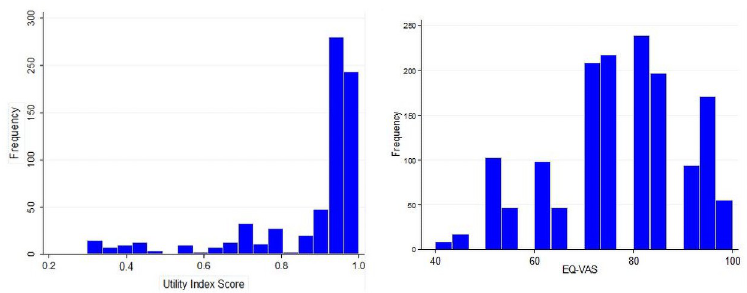
Fig 2. Distribution of the EQ-5D-5L utility and EQ-VAS scores of patients with